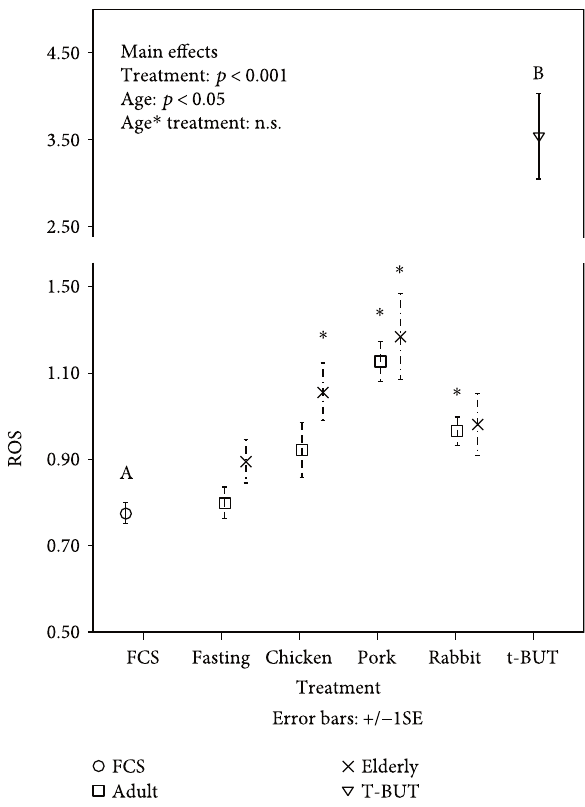
Figure 1: E ff ect of postprandial serum from adult ( □ ) and elderly volunteers ( × ) after consumption of chicken, pork, or rabbit meat meals on HCAEC ROS production. Data are shown as mean ± SEM. All data are compared to fasting serum, fetal calf serum (FCS, marked by “ ○ ” ) and the strong oxidant tert-butyl hydroperoxide (t-BUT, marked by “ ∇ ” ). In the left-high panel are reported the signi fi cance of the main e ff ects: age, treatment (postprandial versus fasting), and their interaction analyzed by generalized linear models. All other comparisons are derived from posthoc by LSD: ∗ p < 0 05 versus the respective fasting serum, A p < 0 01 versus all postprandial sera (chicken, pork, and rabbit), and B p < 0 01 versus all other treatments. Pooled samples used for the experiments were n = 6 (elderly) and n = 10 (adult). Each sample was run as a technical triplicate. For control conditions, n = 10 (FCS) and n = 6 (t-BUT).